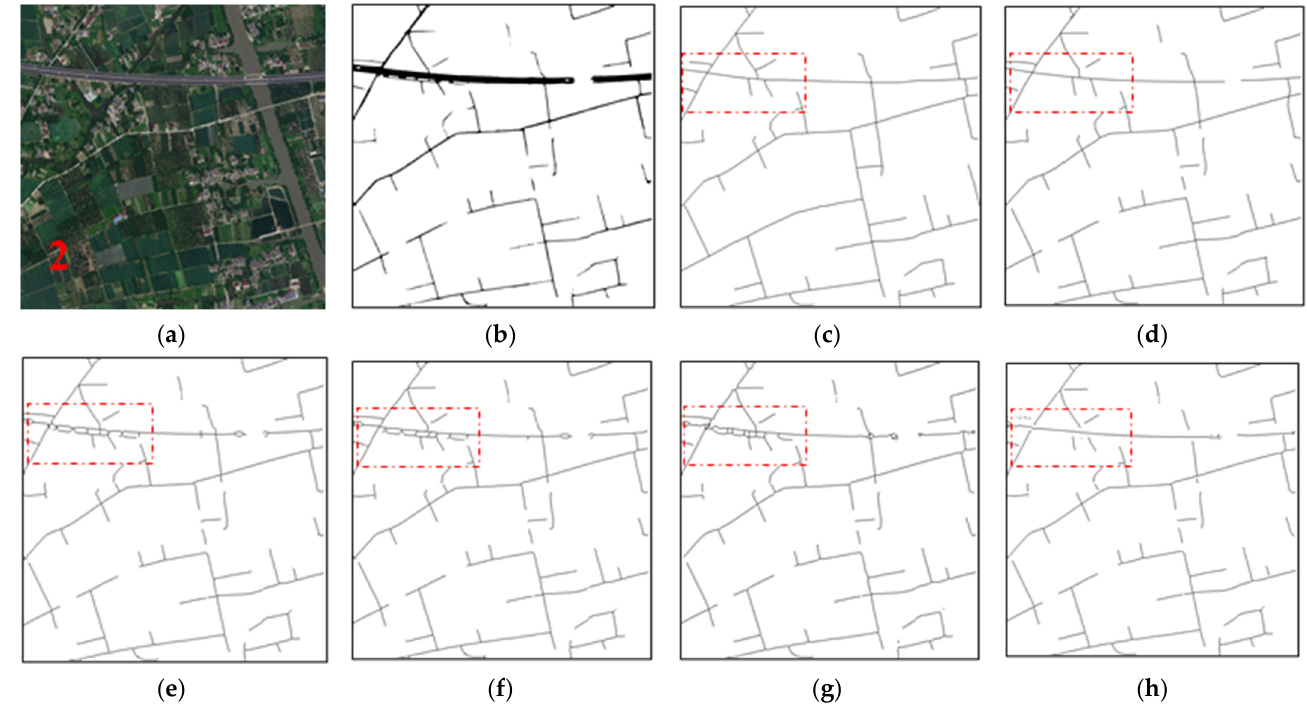
Figure 10. Experimental results for test image 2. ( a ) Original optical image. ( b ) Segmented road map. ( c ) Reference centerline map. ( d ) Result of the proposed method. ( e ) Result of the MT method. ( f ) Result of the ZST method. ( g ) Result of the MARS method. ( h ) Result of the NMS method. Table 2. Quantitative indexes of centerline extraction in test images 1 and 2 with different methods.